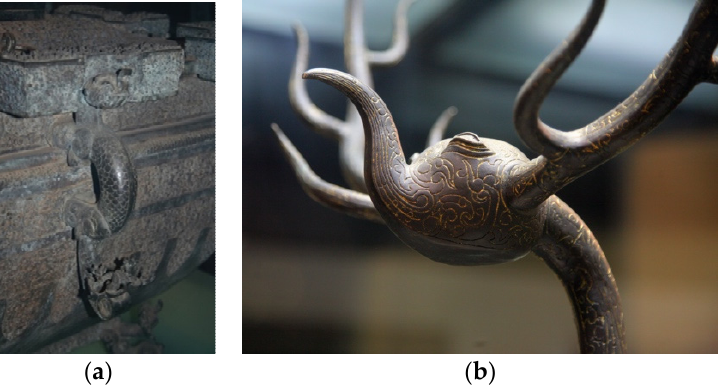
Figure 7. ( a ) Detail of bronze jian fou excavated from the Tomb of the Marquis Yi of Zeng. Hubei Provincial Museum. Photo by author. ( b ) Detail of head of bronze crane excavated from the Tomb of the Marquis Yi of Zeng. Hubei Provincial Museum. Photo courtesy of Larry F. Ball.